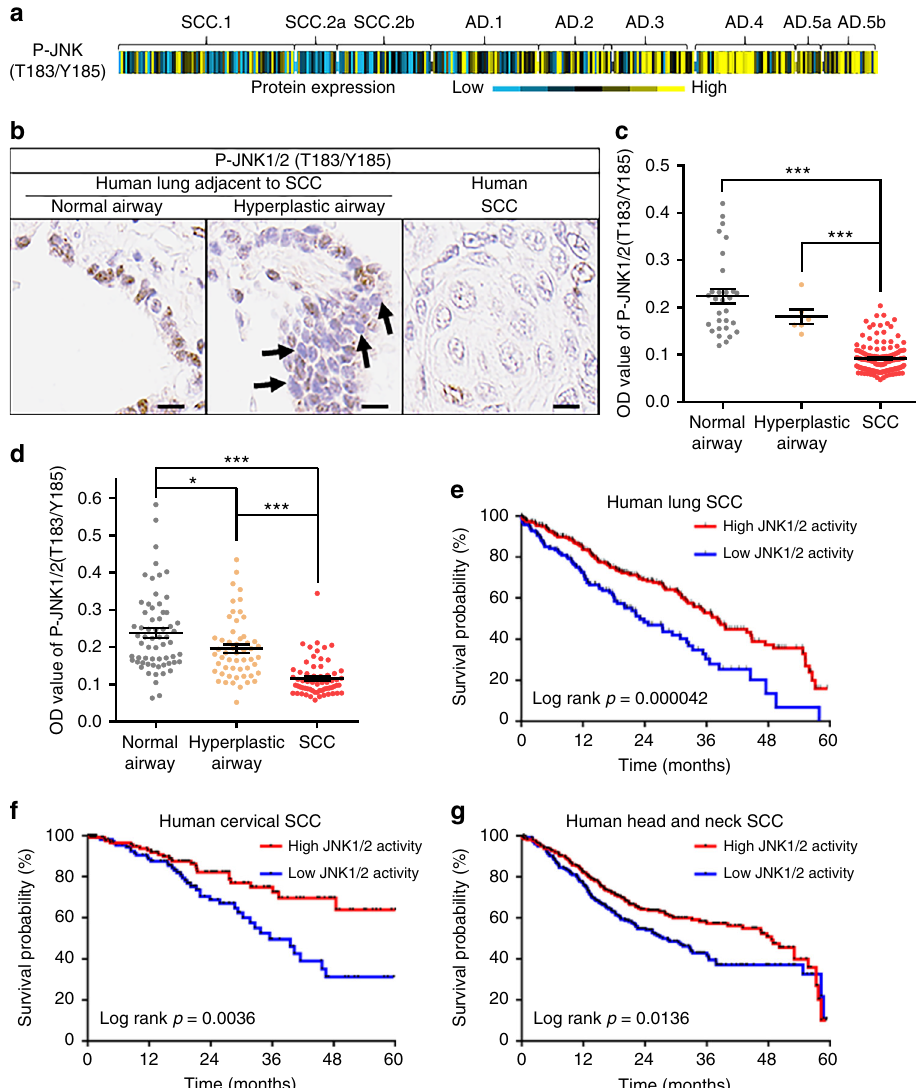
Fig. 1e) and in Lkb1 d/d Jnk1 d/d Jnk2 − / − (Fig. 4b) mice, but both epithelial hyperplasia and adenomas had negative expression of p63 and CK5 in Kras G12D mice (Supplementary Fig. 2f). Consistent with the observations in human lung cancers, these mouse results show that epithelial hyperplasia can develop into SCC, AD or ASC, and the developmental direction of epithelial hyperplasia can be re fl ected by expression of these markers, such as p63 and CK5 for SCC and TTF1 for AD. In the ASCs,